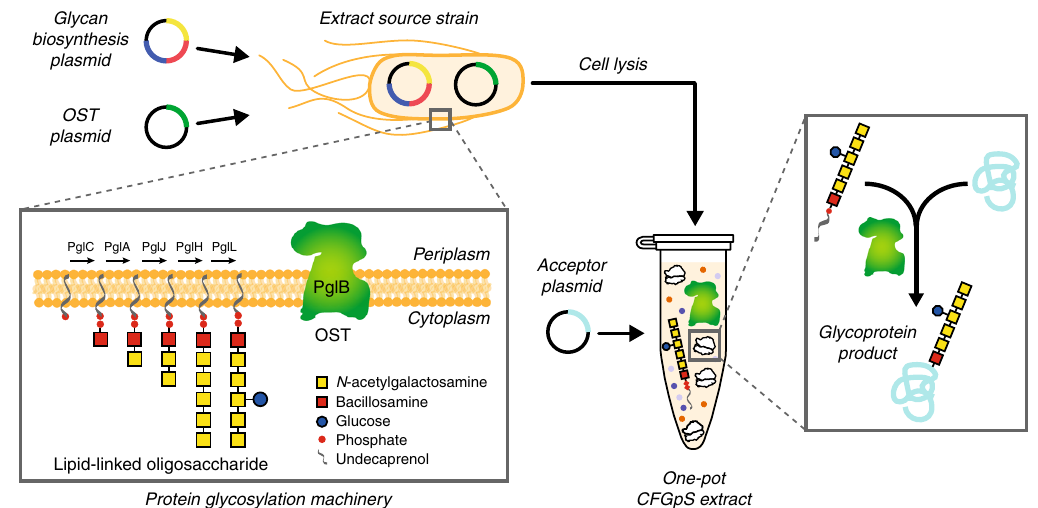
Fig. 1 Schematic of single-pot CFGpS technology. Glycoengineered E. coli that are modi fi ed with (i) genomic mutations that bene fi t glycosylation reactions and (ii) plasmid DNA for producing essential glycosylation components (i.e., OSTs, LLOs) serve as the source strain for producing crude S30 extracts. Candidate glycosylation components can be derived from all kingdoms of life and include single-subunit OSTs like C. jejuni PglB and LLOs bearing N -glycans from C. jejuni that are assembled on Und-PP by the Pgl pathway enzymes. Following extract preparation by lysis of the source strain, one-pot biosynthesis of N- glycoproteins is initiated by priming the extract with DNA encoding the acceptor protein of